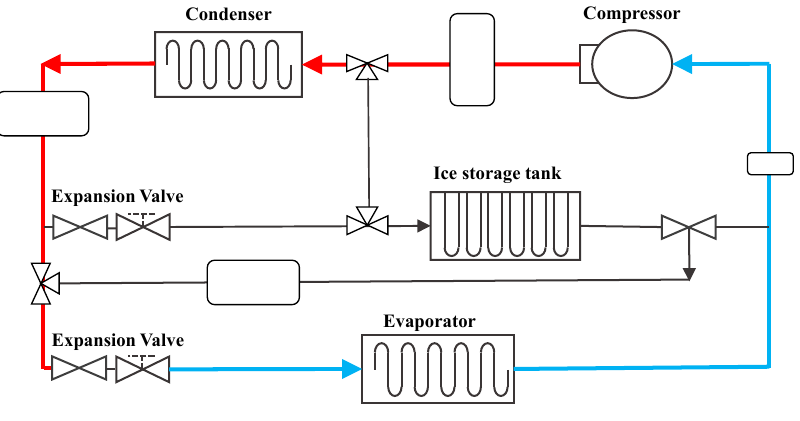
Figure 3. Schematic of the refrigeration mode.